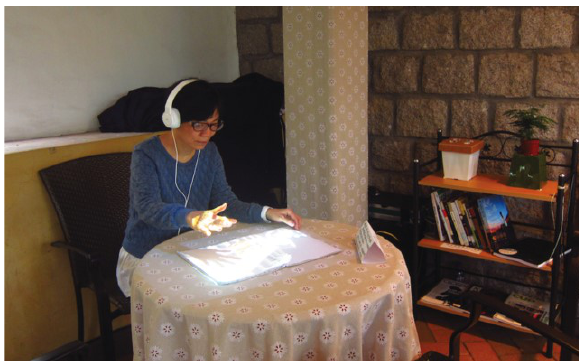
Figure 3 | Digital olfactory artwork provided intangible experience in the heritage